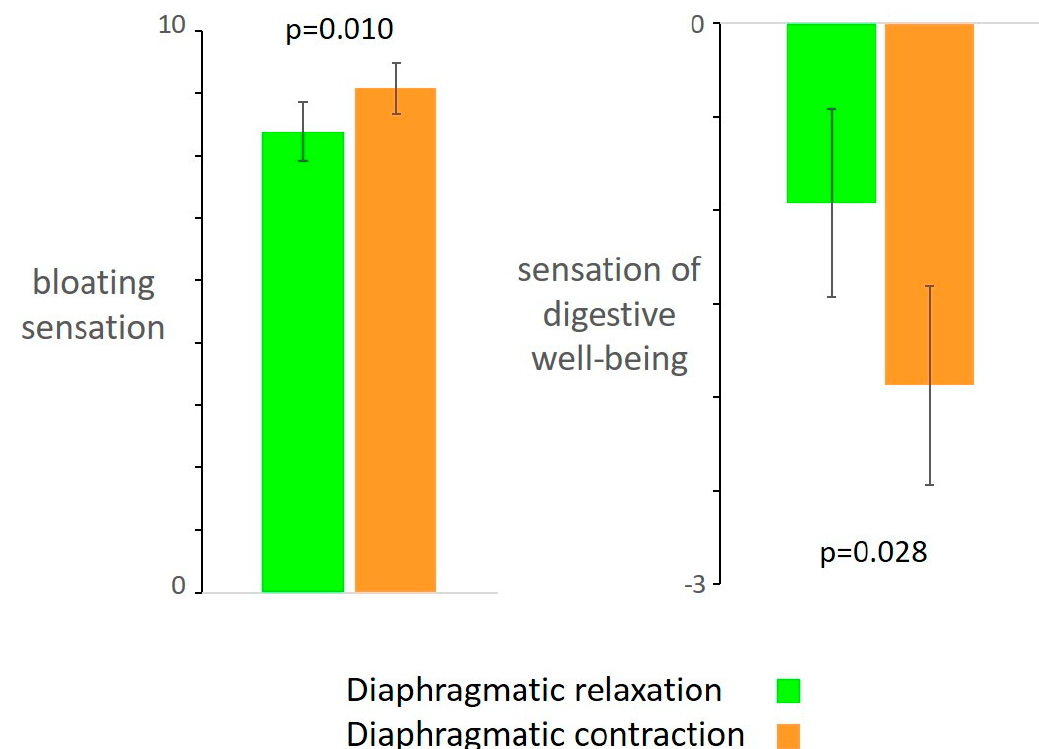
Figure 2. Effect of somatic maneuvers on digestive sensations. Diaphragmatic contraction (i.e., intentional abdominal distension) was associated with increased postprandial bloating and impaired digestive well-being.